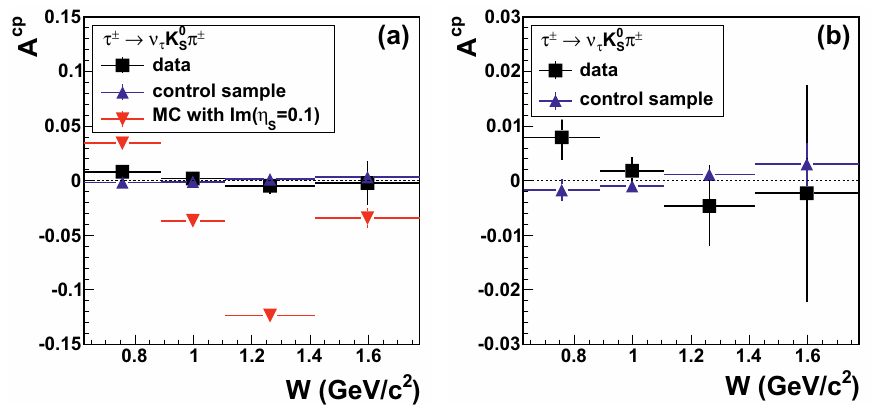
Figure 2. The CP asymmetry, A CP i , measured by BELLE[30, Figure 2]. The vertical bars represent the statistical and systematic uncertainties added in quadrature for Data. For the control sample, the vertical error bars represent the statistical uncertainty. The di ff erence between the left-hand plot (a) and the right-hand plot (b) is the scale of A CP i .